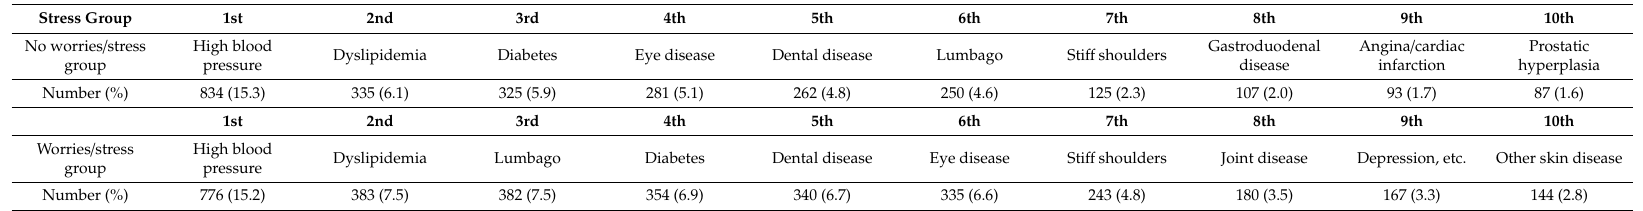
Table 4. Diseases for which there were regular hospital visits with highest frequency of response by stress group (top 10 ranked).